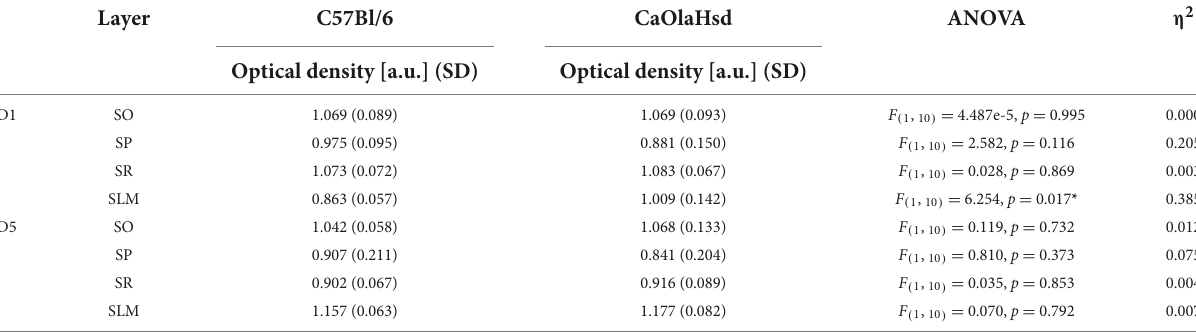
TABLE 1 Statistical comparison of D1 and D5 receptor expression within the layers of CA1 between CaOlaHsd ( n = 6) and C57Bl/6 mice ( n = 6).